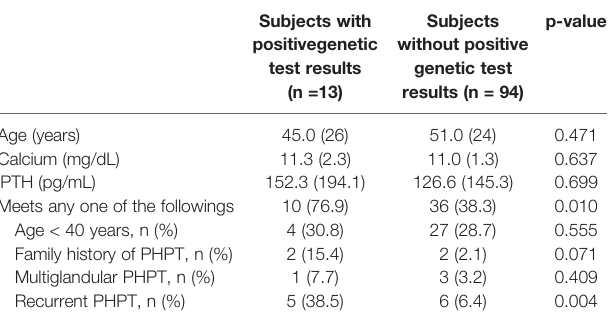
TABLE 4 | Characteristics of subjects according to genetic test